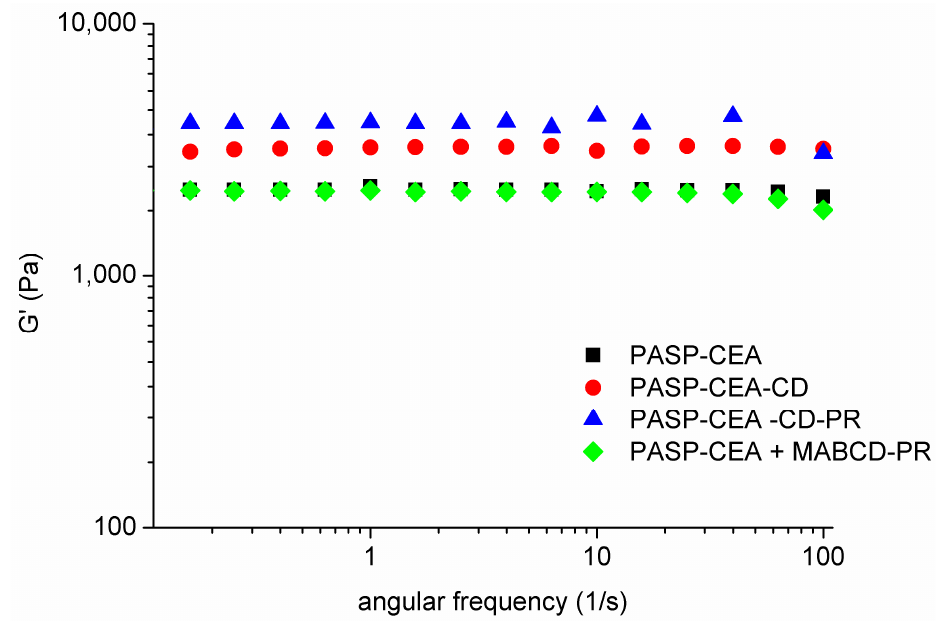
Figure 5. Frequency sweep test of the gel formulations.